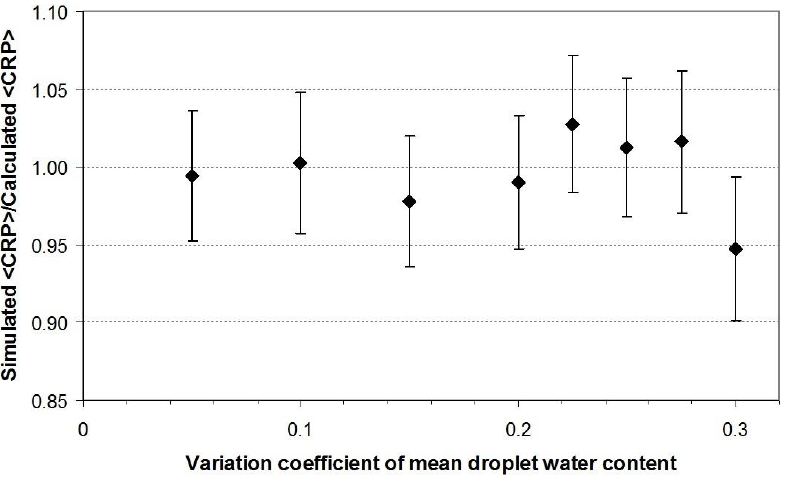
Figure 3. The resulting simulated/calculated <CRP> ratios for different coefficients of variation of the mean droplet water content ( ξ d) in session 10 (error bars indicate standard deviation).